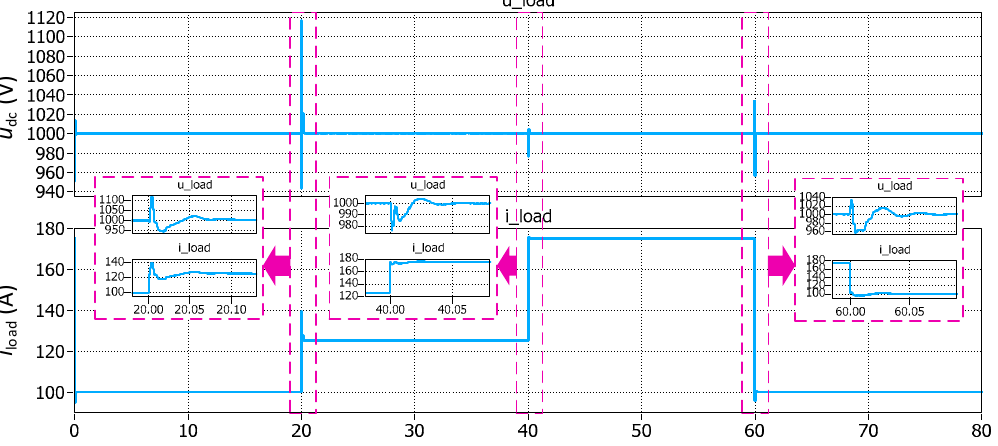
Figure 15. The DC bus voltage and load current during mode switching.